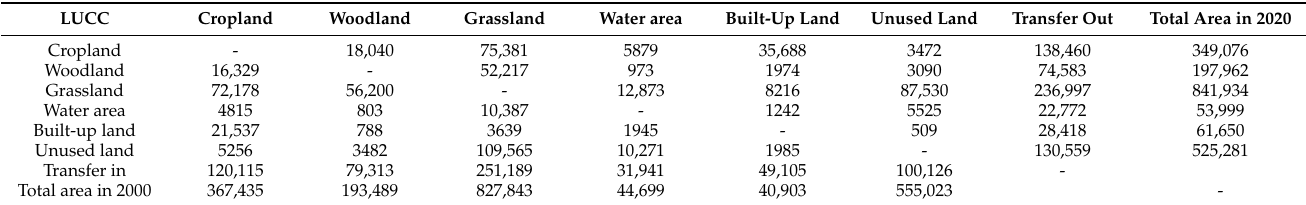
Table 5. Land-usage matrix for the Yellow River Basin 2000–2020 (km 2